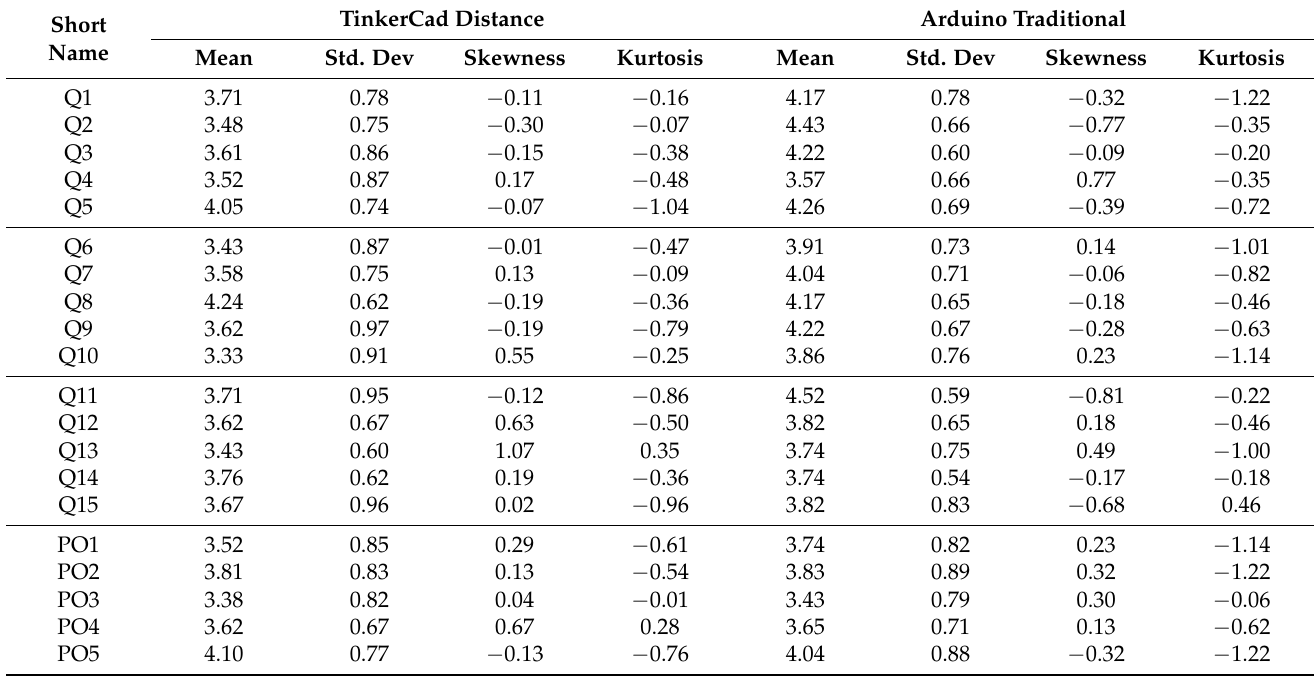
Table 3. Descriptive statistics of the analyzed